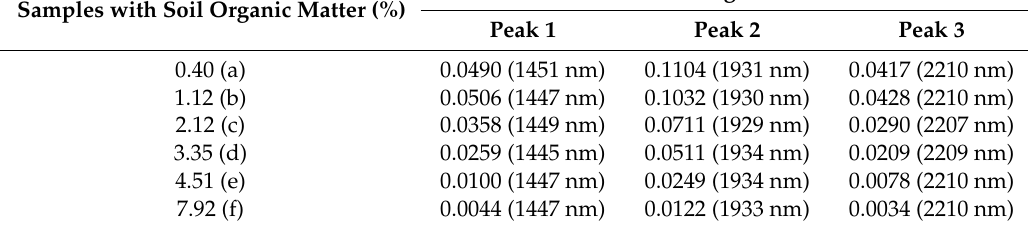
Table 2. Tabulates the correlation strengths of the three main auto-peaks for the soil samples that have been dosed with various moisture content (i.e., moisture as perturbation variable): waveband uncertainty = ± 5 nm.